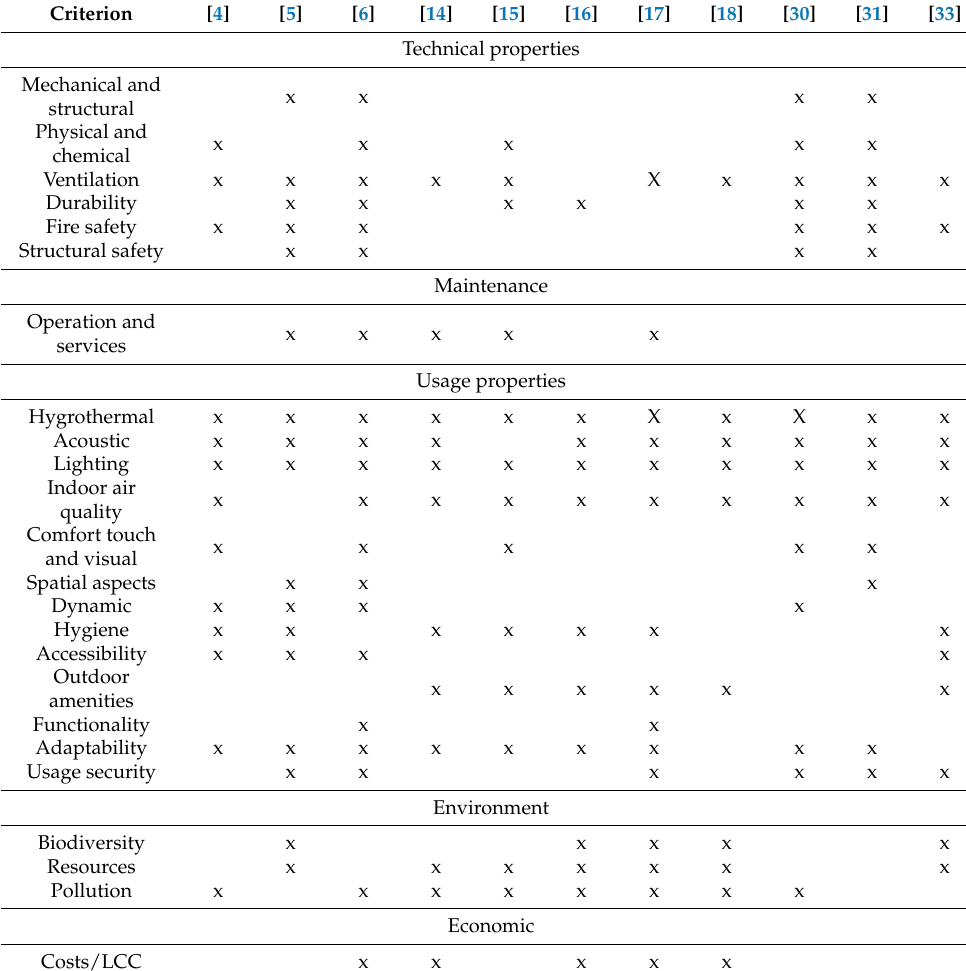
Table 1. Performance criteria in buildings